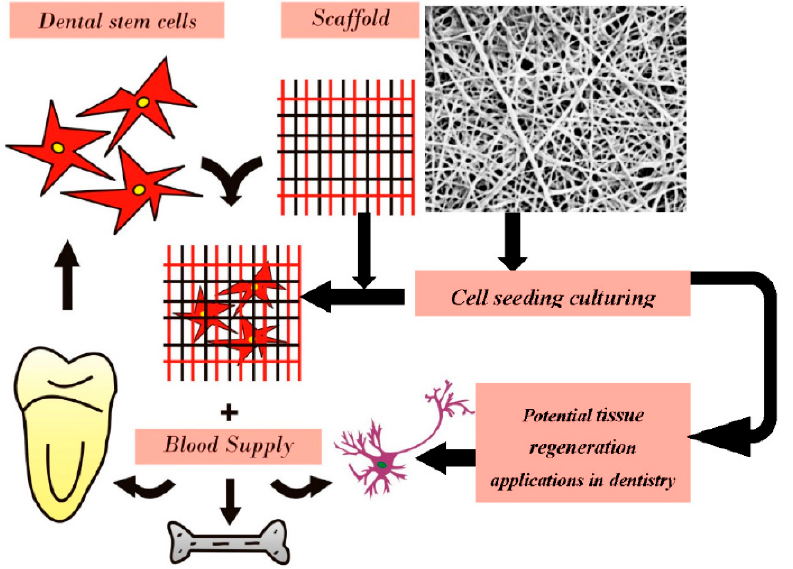
Figure 6. Schematic presentation for implementing electrospun NF implants in dental tissue regen-